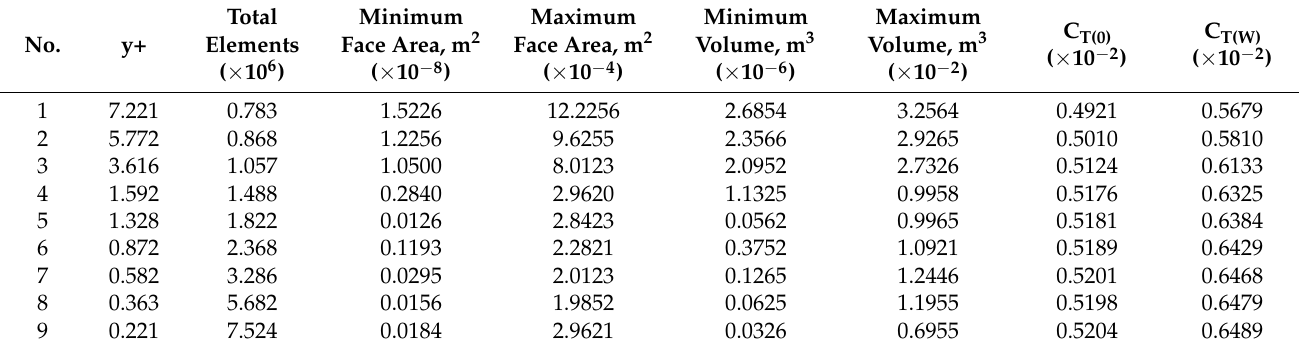
Table 2. Details of the mesh and the CFD results of ship resistance